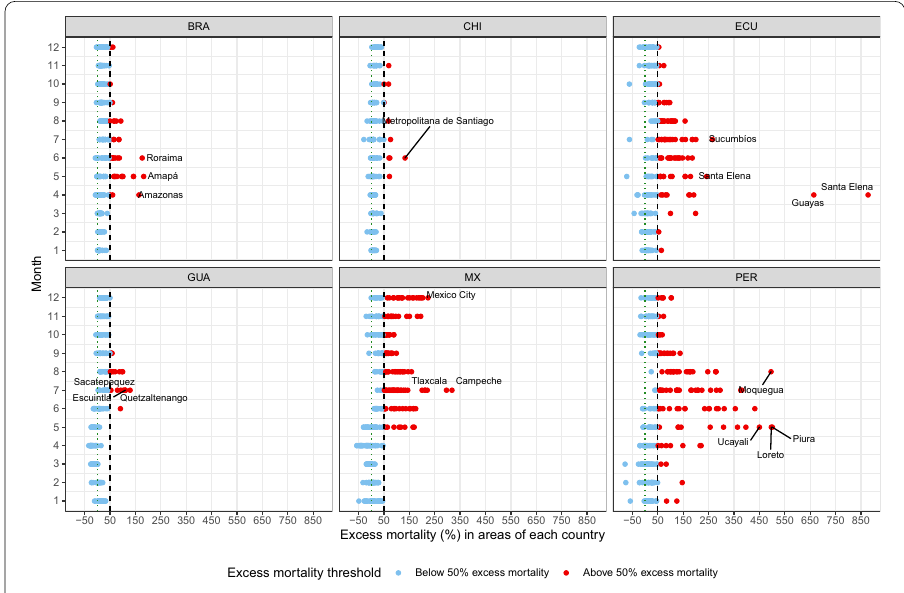
Fig. 1 Excess mortality during the COVID‑19 pandemic: deaths from all causes and ages compared to previous years in selected Latin American countries and their subnational areas in 2020. Threshold of 50 percent excess mortality. Source: Ministry of Health of Brazil, Chile, and Peru, 2021; National Civil Registry Ecuador (Gobierno de la República del Ecuador, 2021); National Registry of Persons Guatemala (RENAP, 2021); and Secretariat of Health, Mexico (DGE‑SS 2021). Names and acronyms of countries are presented in Additional file 4: Table